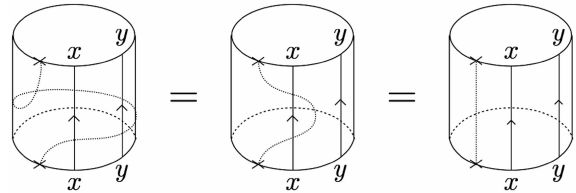
Figure 6 . Winding the auxiliary line around a circle is equivalent to moving the auxiliary line back and forth, both of which are equivalent to doing nothing. This implies that X